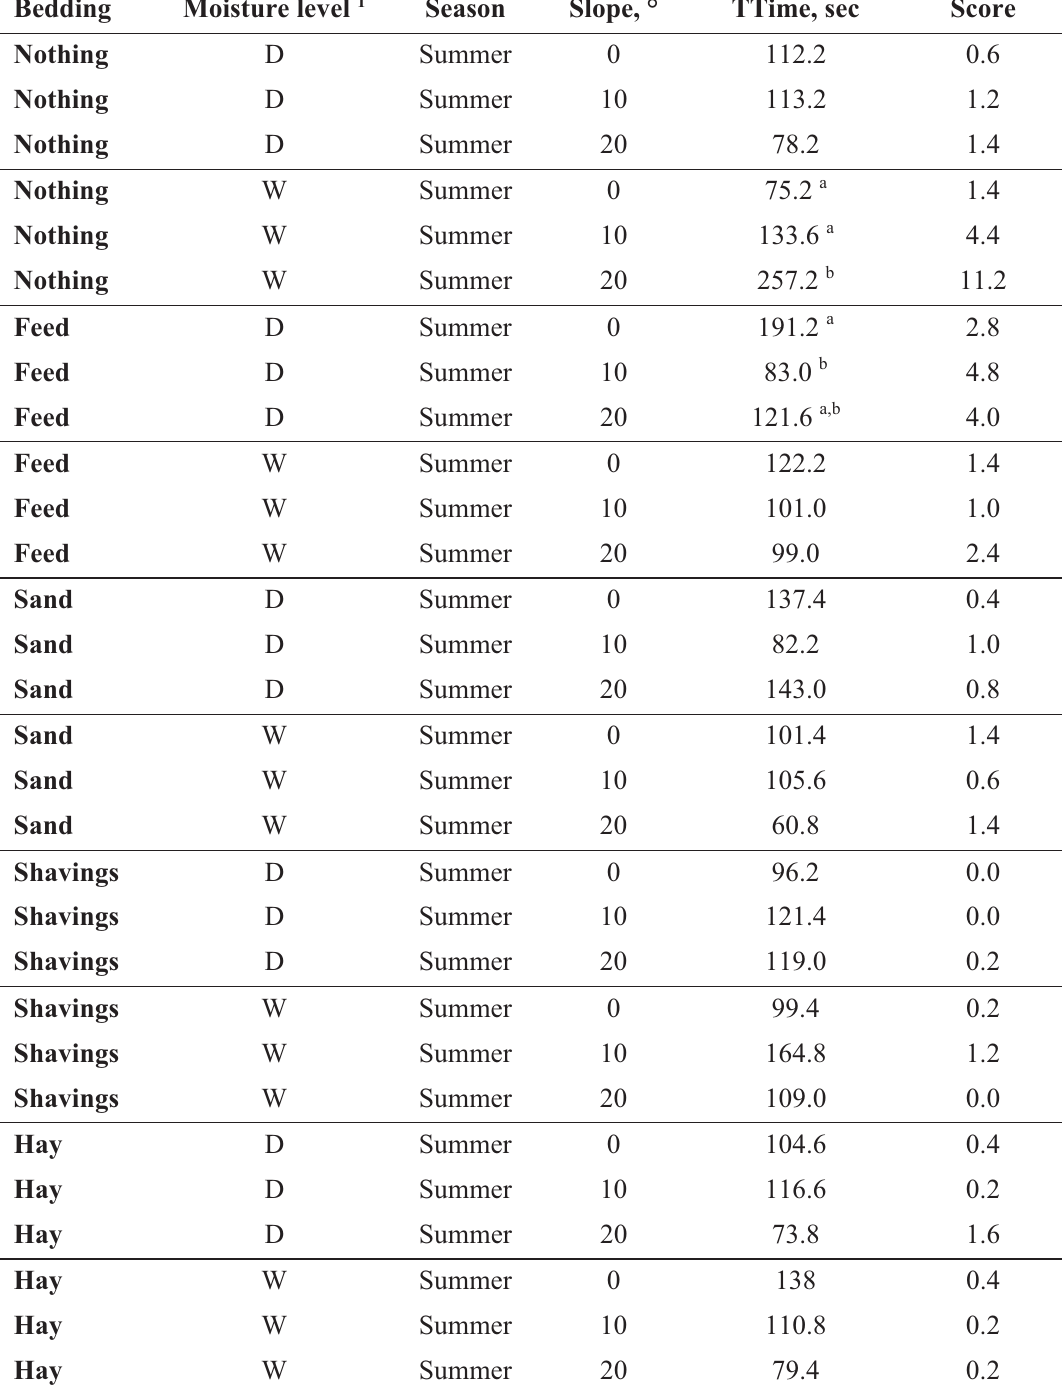
Table 3. Least Squares means ± 39.09 for total time (TTime: sec) spent loading and unloading weaned pigs during the summer in response to the four-way interaction of bedding, moisture level (W/D), season, and slope ( P < 0.05). Score was calculated by the sum of slips, falls, and vocalizations. n = 60